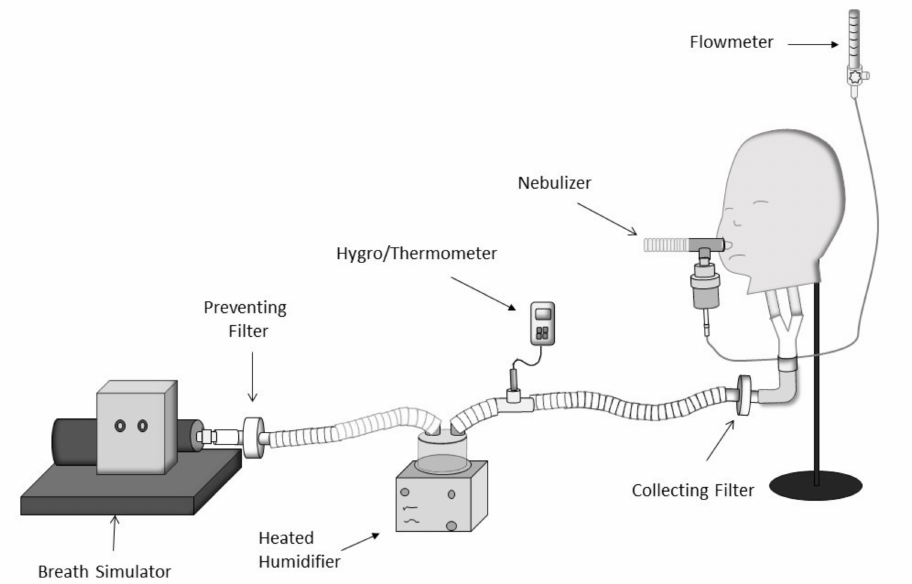
Figure 2. Lung model used to simulate a spontaneously breathing child. Adapted from [21], ERJ Open Research,